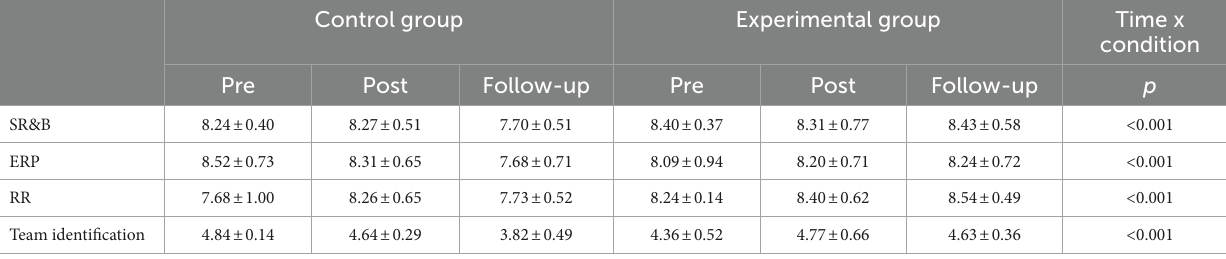
TABLE 2 Results of mixed repeated-measures ANOVA in variables related to team structure.